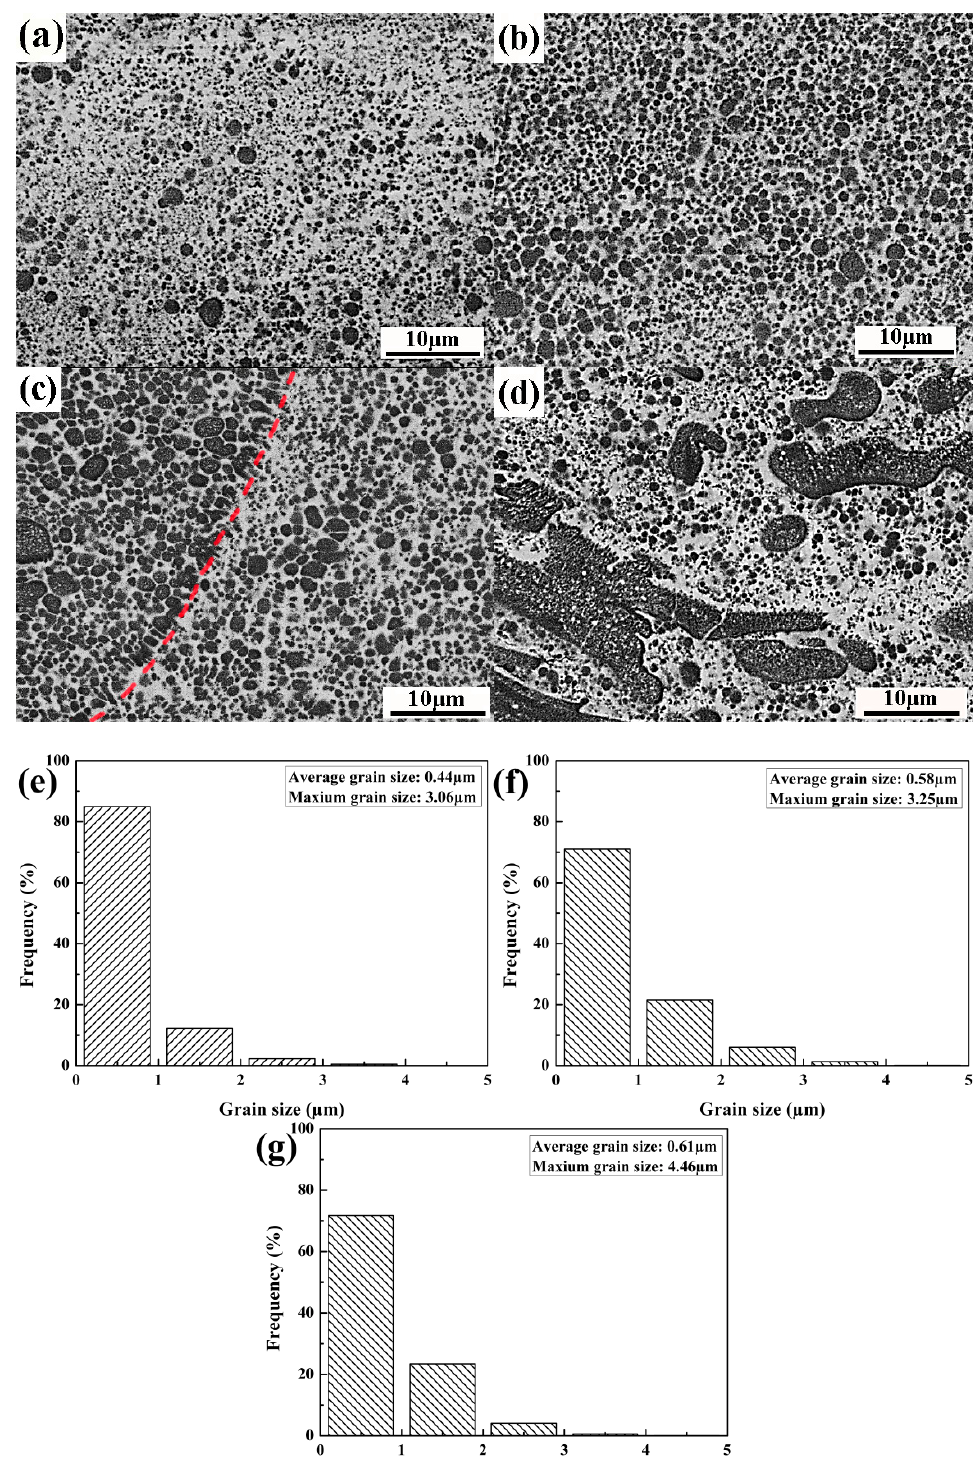
Figure 5. Magnified backscattered electron image of the morphologies of Cr particles in Figure 4b: ( a ) top of the melt pool, ( b ) middle of the melt pool, ( c ) overlap zone of the melt pool, ( d ) bottom of the melt pool, ( e ) the grain size distribution of Cr particles in ( a ), ( f ) the grain size distribution of Cr particles in ( b ), and ( g ) the grain size distribution of Cr particles in ( c ).